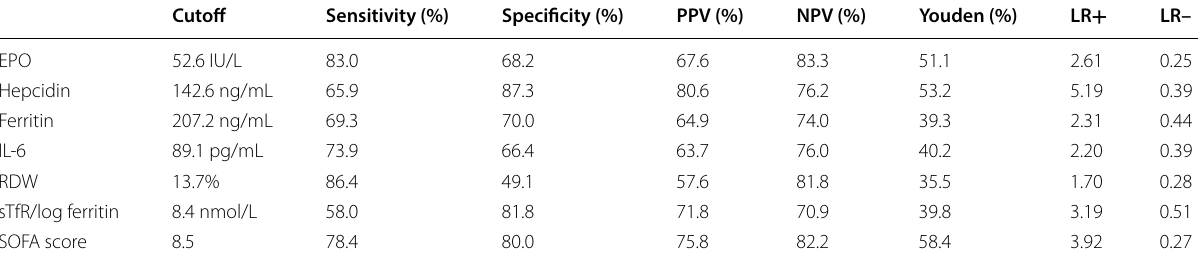
EPO erythropoietin; ICU intensive care unit; IL - 6 interleukin-6; LR positive likelihood ratio; LR – negative likelihood ratio; NPV negative predictive value; PPV positive + predictive value; RDW red blood cell distribution width; SOFA Sequential Organ Failure Assessment; sTfR soluble transferrin receptor